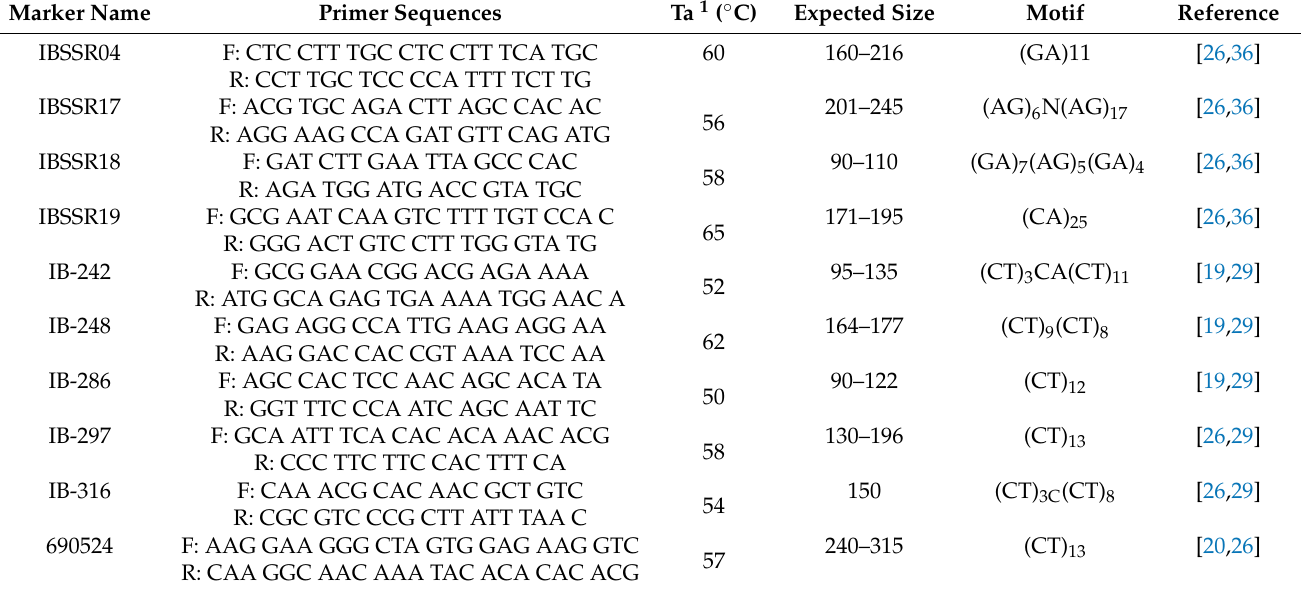
Table 2. List of SSR markers with annealing temperature, expected size, and motif used in the genotyping of 31 selected sweetpotato